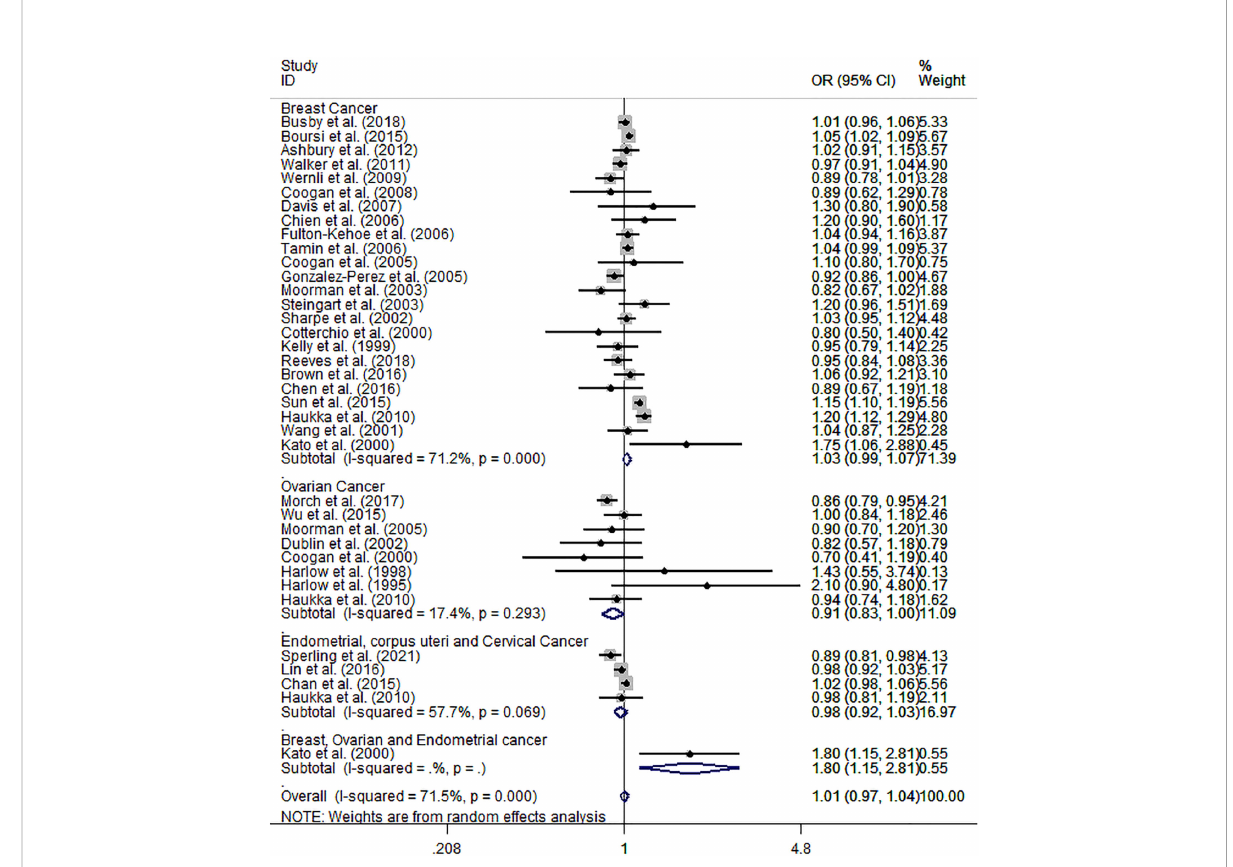
FIGURE 2 Forest plot of ever vs. never antidepressant use and incidence risk of breast and gynecological